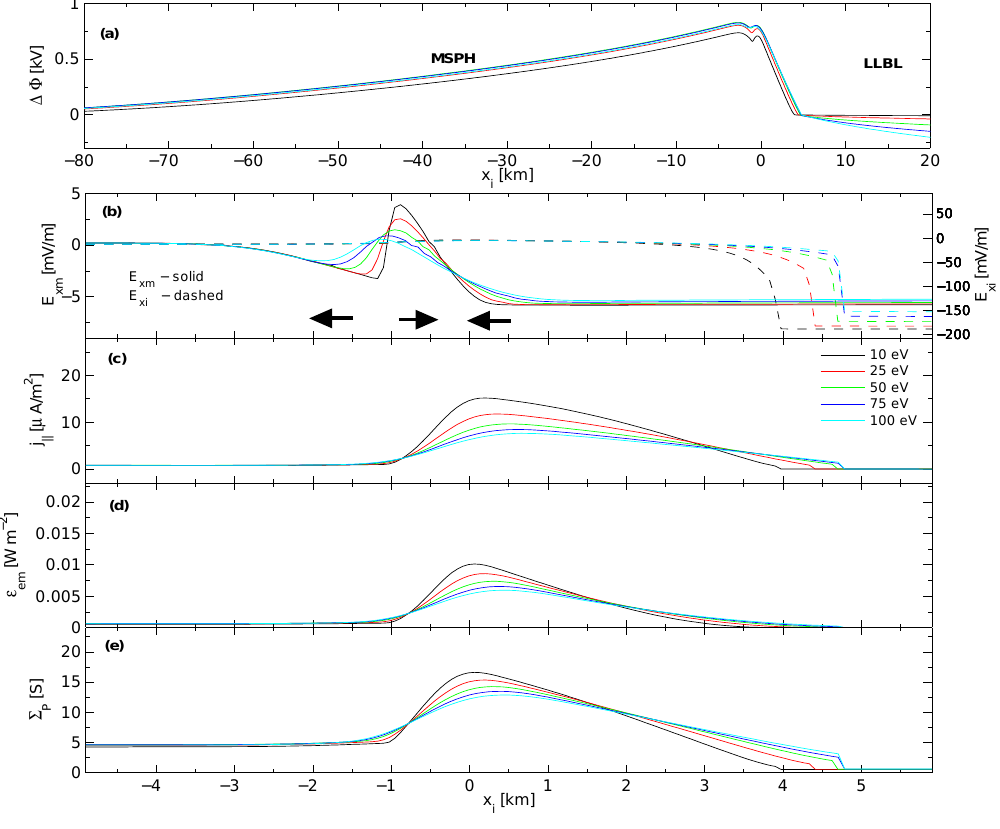
Fig. 9. Solutions of Eq. (4) and derived quantities obtained for a non-uniform height-integrated Pedersen conductivity with background 6 P 0 = 0 . 5 (see Eq. 2). Different colors illustrate solutions obtained for various profiles of 8 m obtained for five different various electron temperatures at the LLBL side of the TD. The values of T − corresponding to each color are given in the legend of panel (d) See caption LLBL of Fig. 5 for